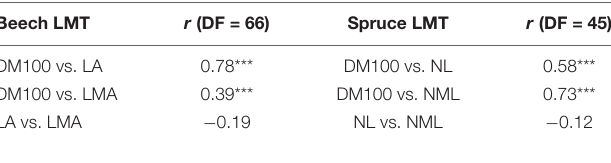
TABLE 3 | Pearson correlations ( r , correlation coefficient; DF, degrees of freedom) between leaf morphological traits (LMTs) averaged over plot and year, for beech and for spruce.